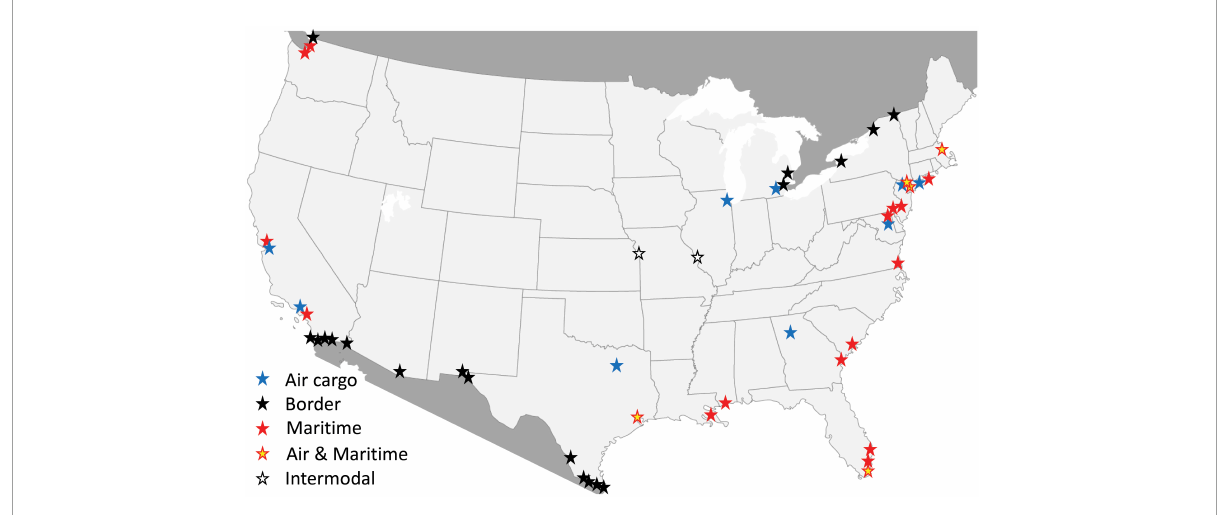
FIGURE1 All ports in the contiguous 48 US states where WPM was inspected as part of the AQIM program during 2003–2020. Not shown are the participating ports of Honolulu, HI and San Juan, PR. Source of base map: